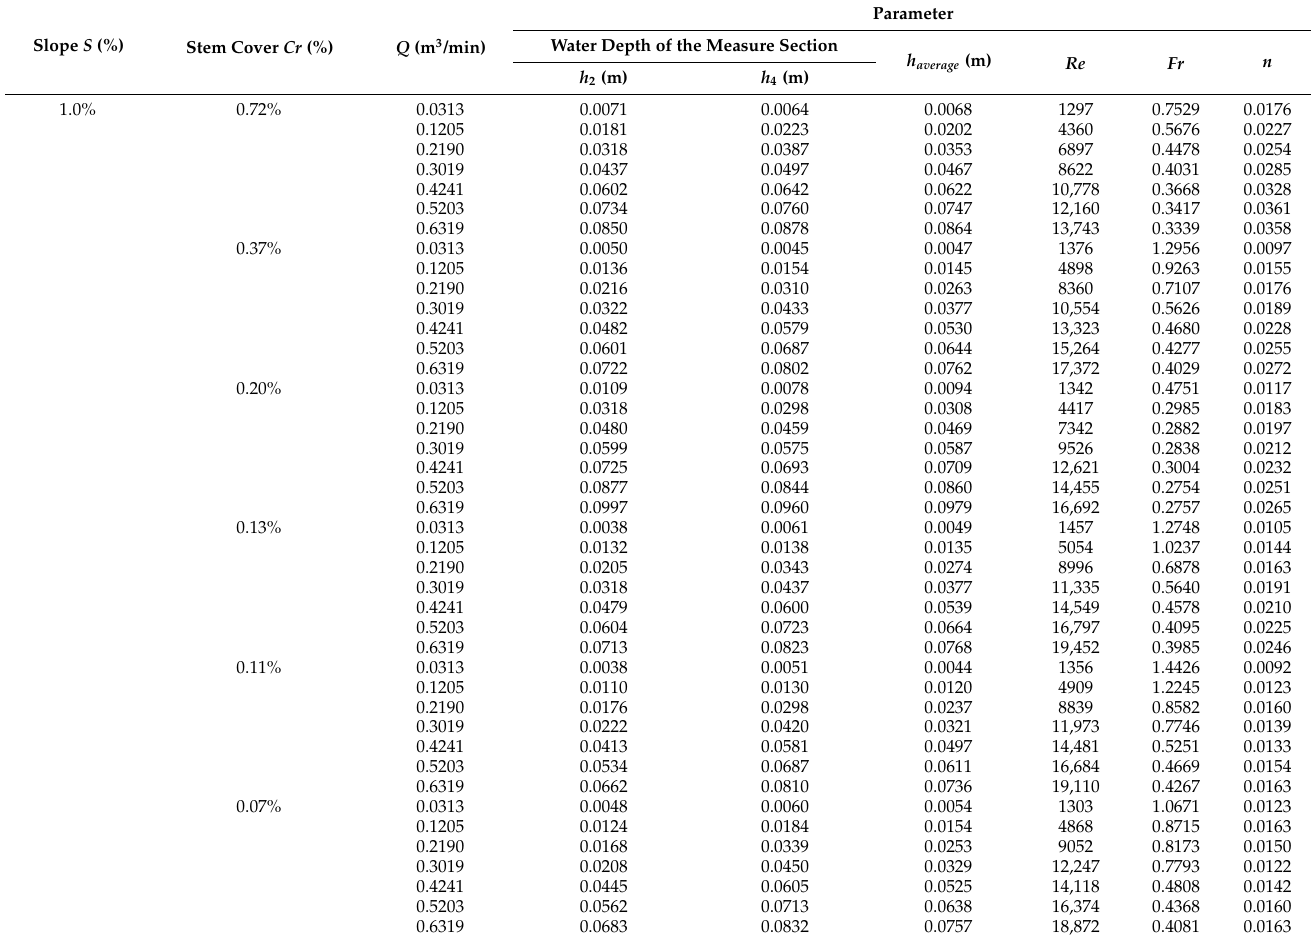
Table 2. Experimental data of hydraulic parameters of six different vegetation stem cover under the condition of S = 1.0% ( Cr is 0.72%, 0.37%, 0.20%, 0.13%, 0.11% and 0.07%,